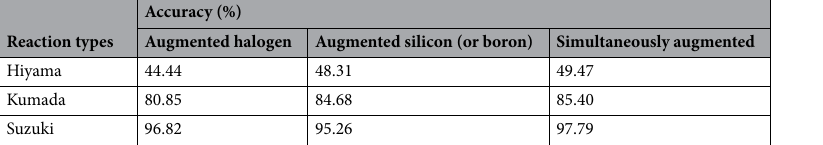
Table 5. The comparisons of different augmented